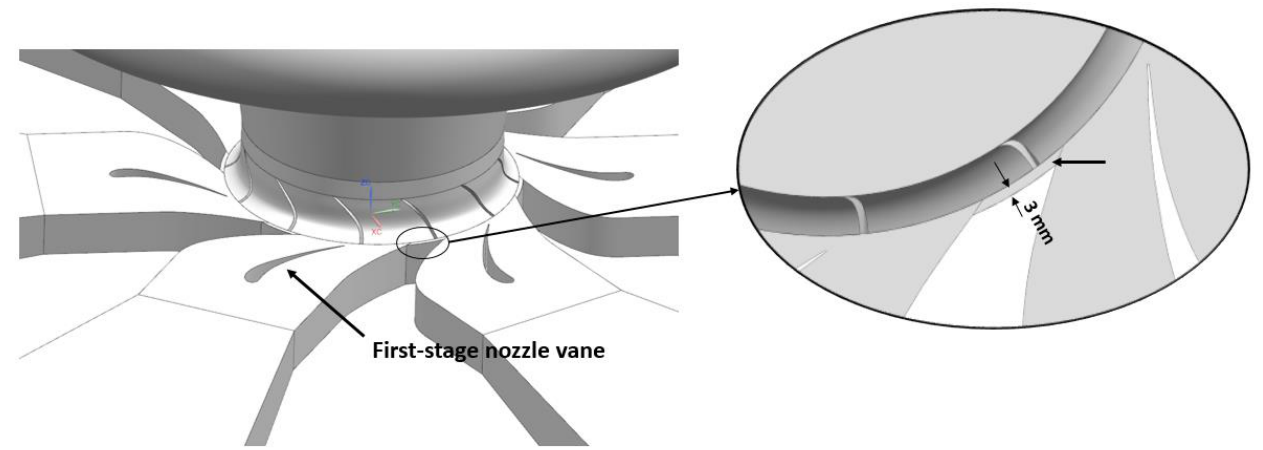
Figure 6. The first-stage nozzle vane and rotor gap.